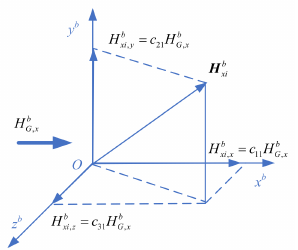
Figure 3. Schematic diagram of